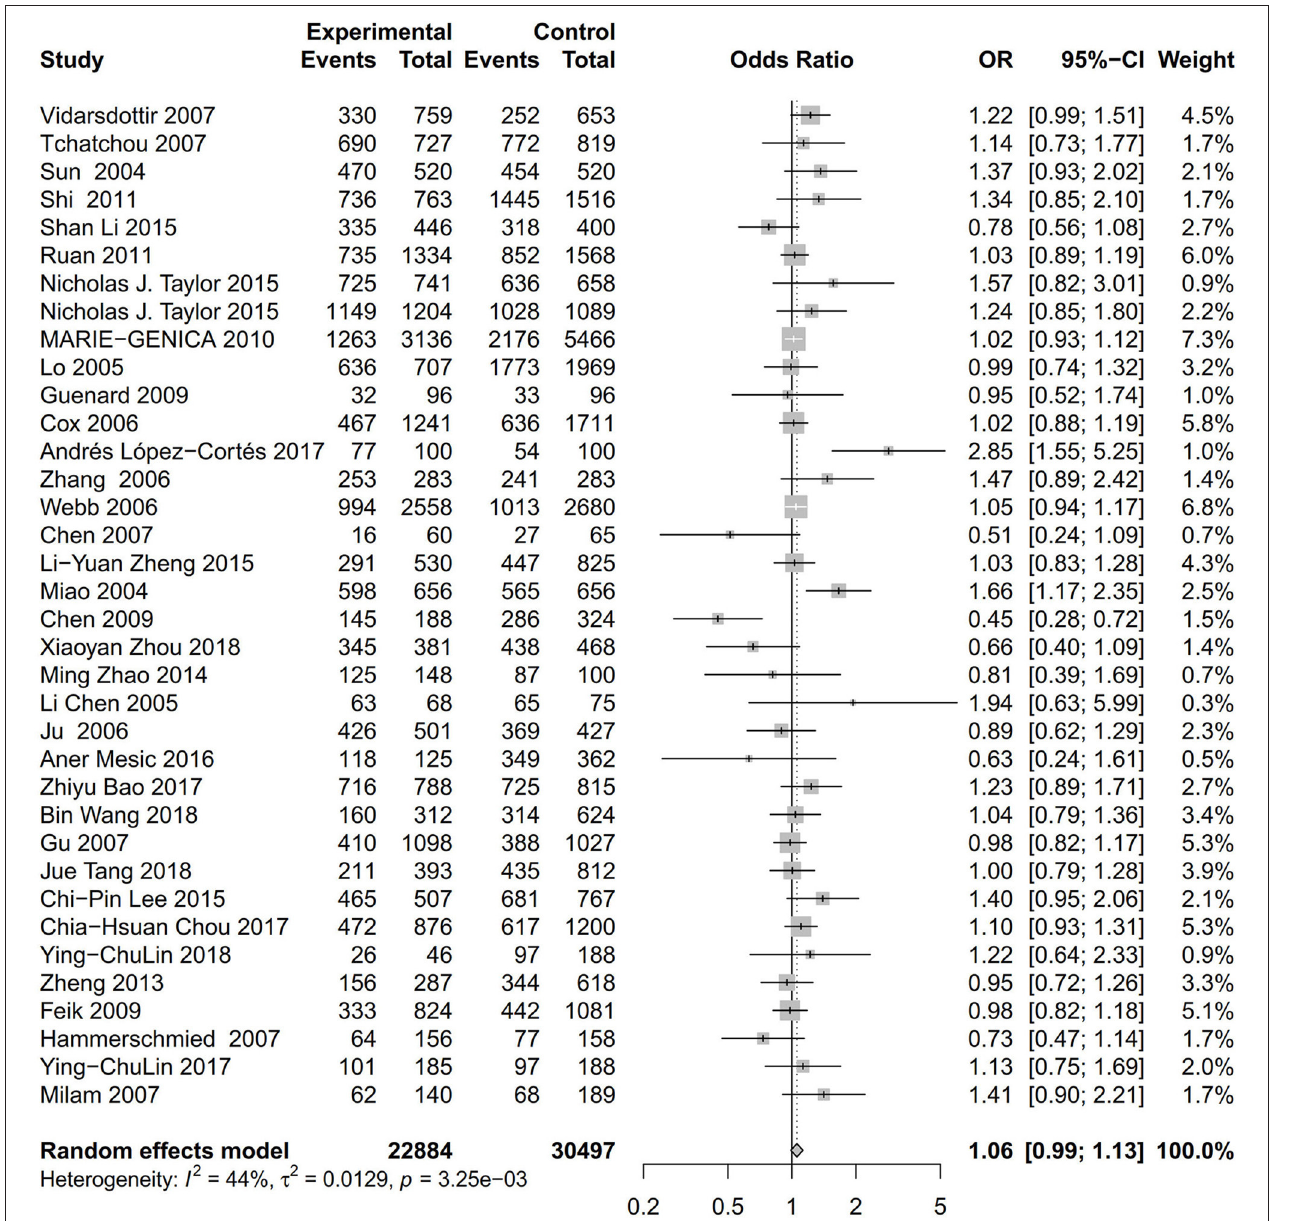
FIGURE 2 | Forest plot of the association between the AURKA rs2273535 T > A polymorphism and overall cancer risk under the dominant model (AT + AA vs. TT).